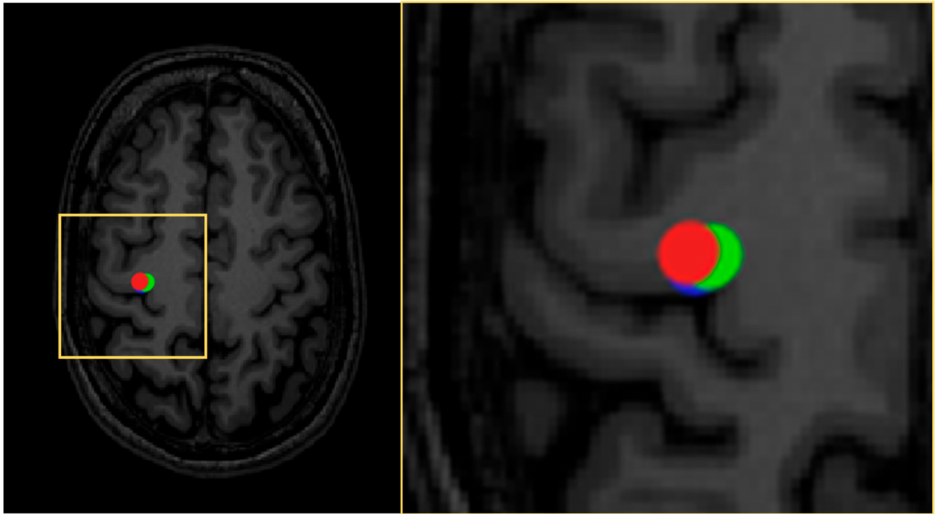
Figure 11. Visualization of CoGs based on motor maps with three SIs (blue: 110% of the rMT, green: Mills–Nithi UT method [108], red: 120% rMT). Data from each of the experiments were bootstrapped 1000 times, assuming that 10% of the responses observed were false negative. The dots indicate a product of 1000 CoG locations each. The image is visualized in neurological